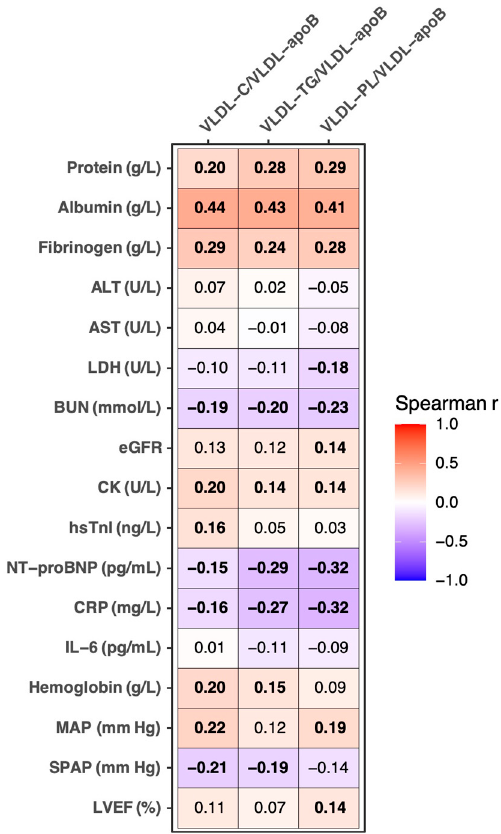
Figure 1. Heatmap for correlations between the ratios estimating VLDL lipid content and laboratory and clinical parameters. Values presented are the Spearman correlation coefficients. The p -values <0.017 are considered significant after a Bonferroni correction for multiple testing and significant correlations are depicted in bold. SPAP was measured in 259 patients; otherwise, the analyses are based on 314 samples for VLDL-C/VLDL-apoB and VLDL-PL/VLDL-apoB, respectively, and 313 for VLDL-TG/VLDL-apoB. BUN, blood urea nitrogen; CK, creatine kinase; CRP, C-reactive protein; eGFR, estimated glomerular filtration rate; hsTnI, high-sensitivity troponin I; LDH, lactate dehydrogenase; MAP, mean arterial pressure; NT-proBNP, N-terminal pro brain natriuretic peptide; SPAP, systolic pulmonary pressure.